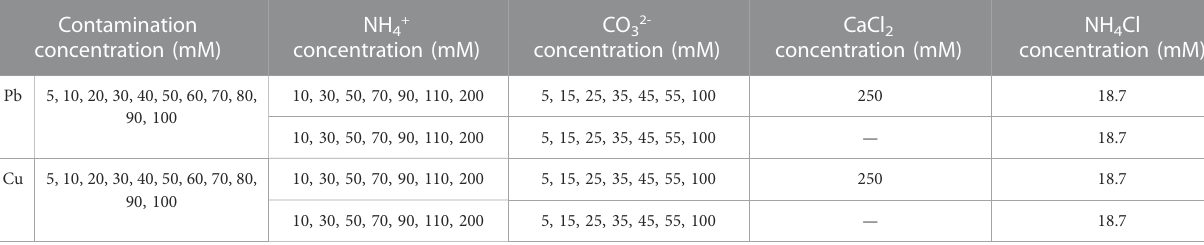
TABLE 3 Summary of the input parameters applied to the numerical